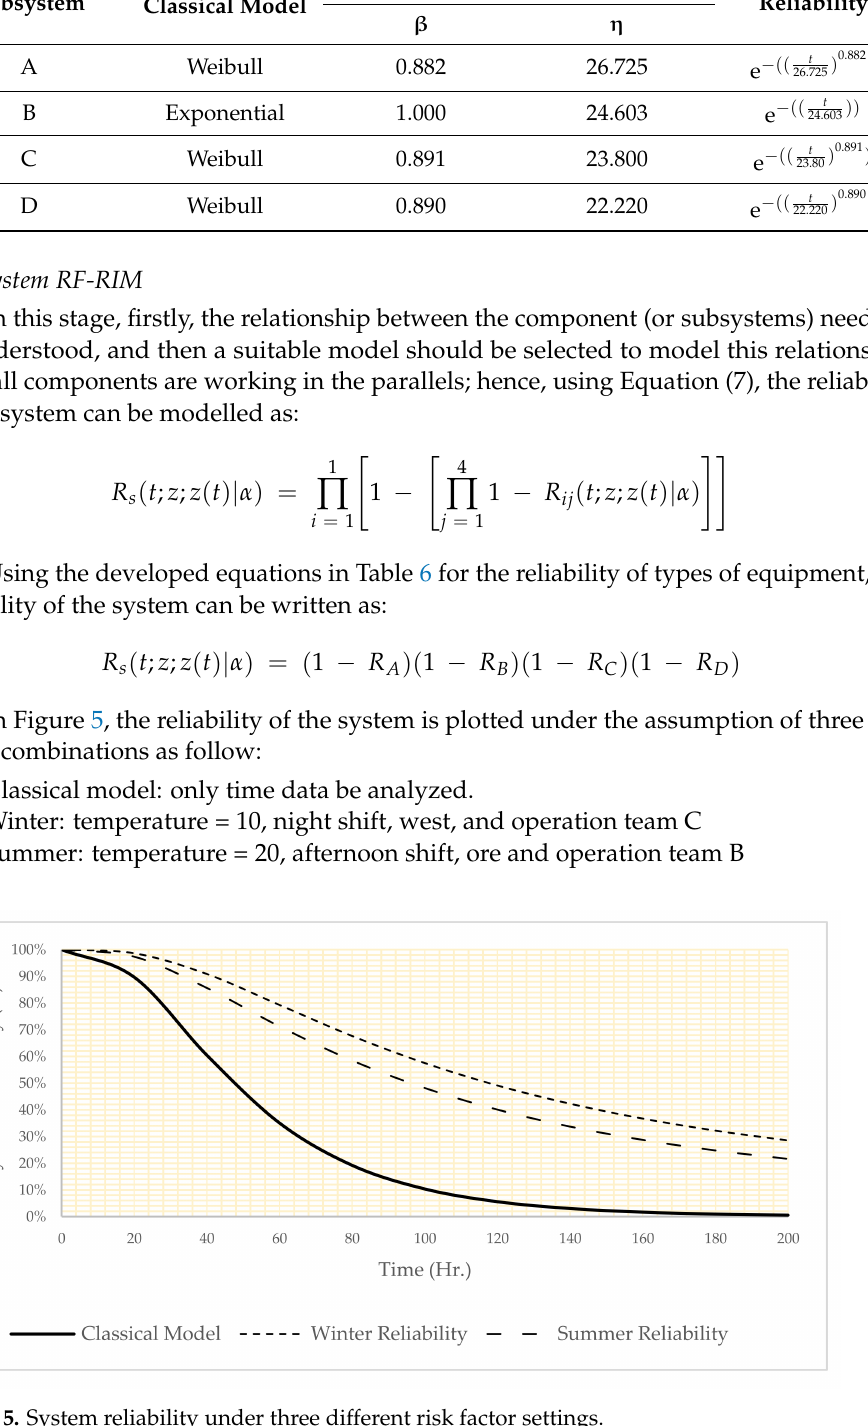
Figure 5. System reliability under three different risk factor